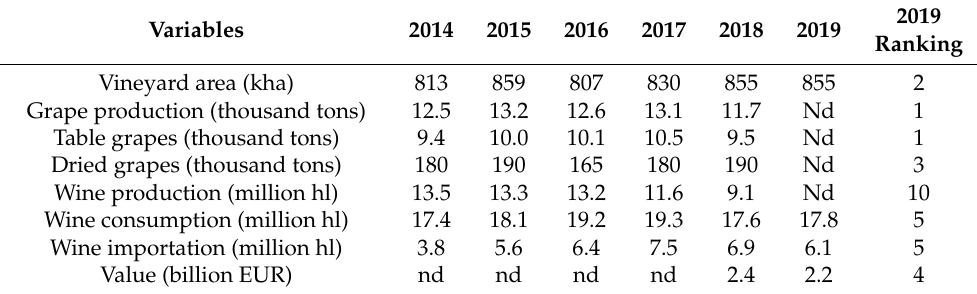
Table 1. Characterization of Chinese viticulture in the worldwide context. Data obtained from the OIV (International Organization of Vine and Wine) reports published in 2018 and 2019; nd: no data are available for these parameters or Chinese vineyards were not ranked on the top